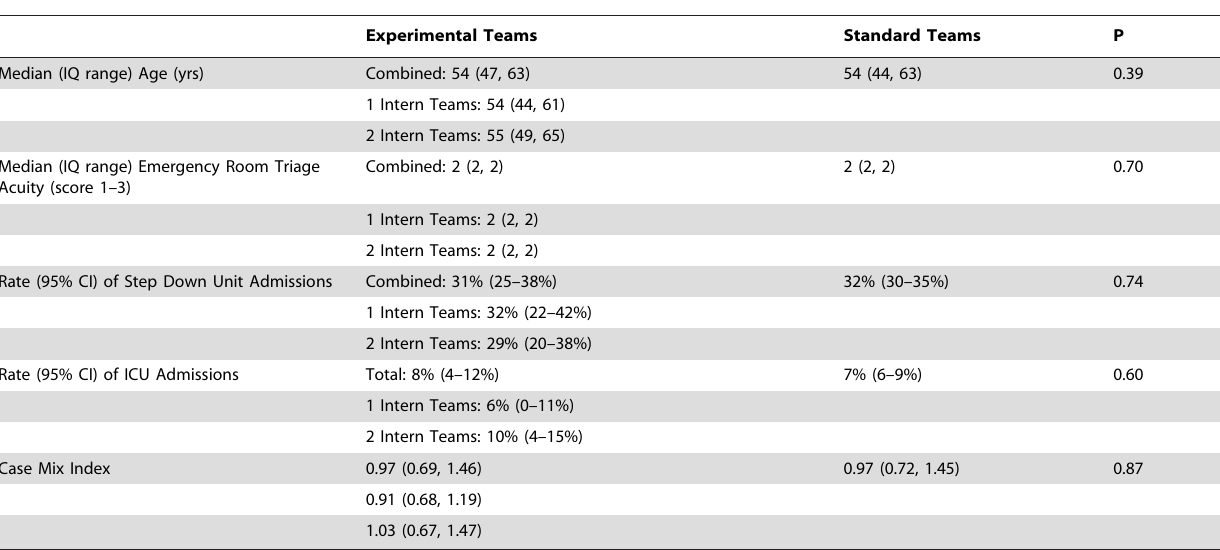
Table 3. Comparison of Patients on Experimental vs. Standard Teams.